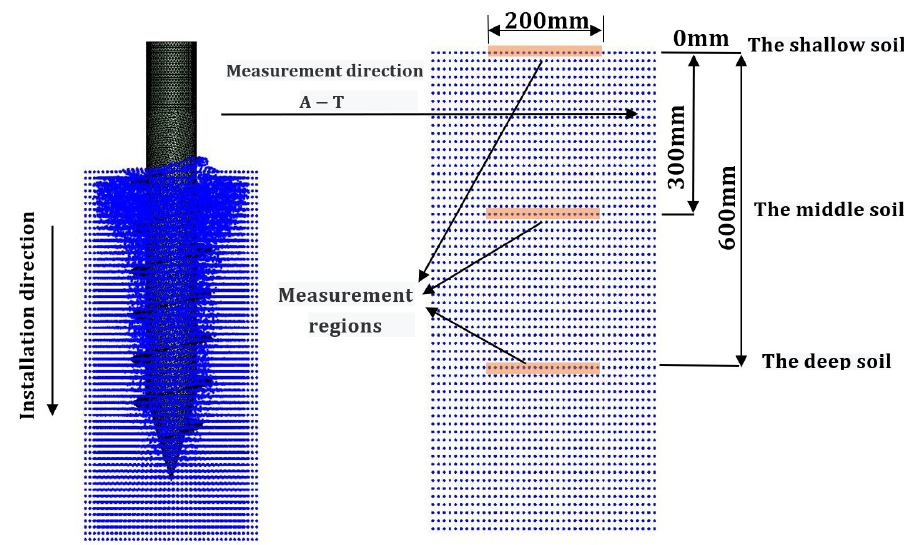
Figure 13. Arrangement of measurement regions.